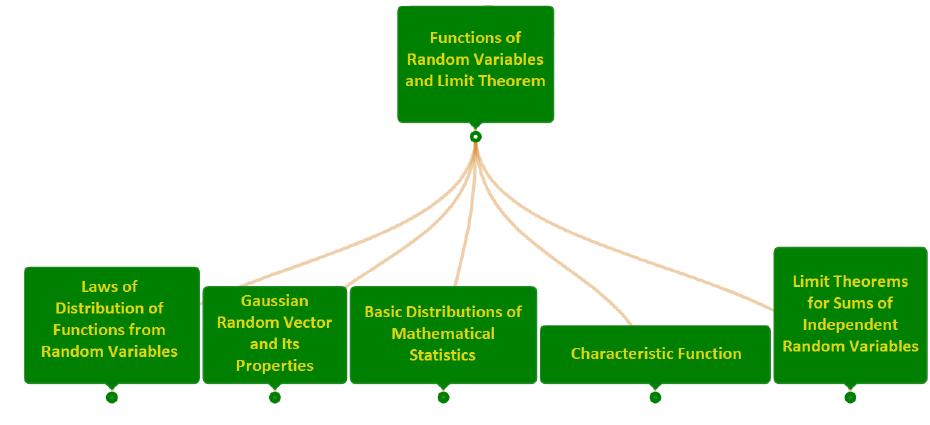
Fig. 2. Structure of Chapter 4 of PTMS e-course: division into